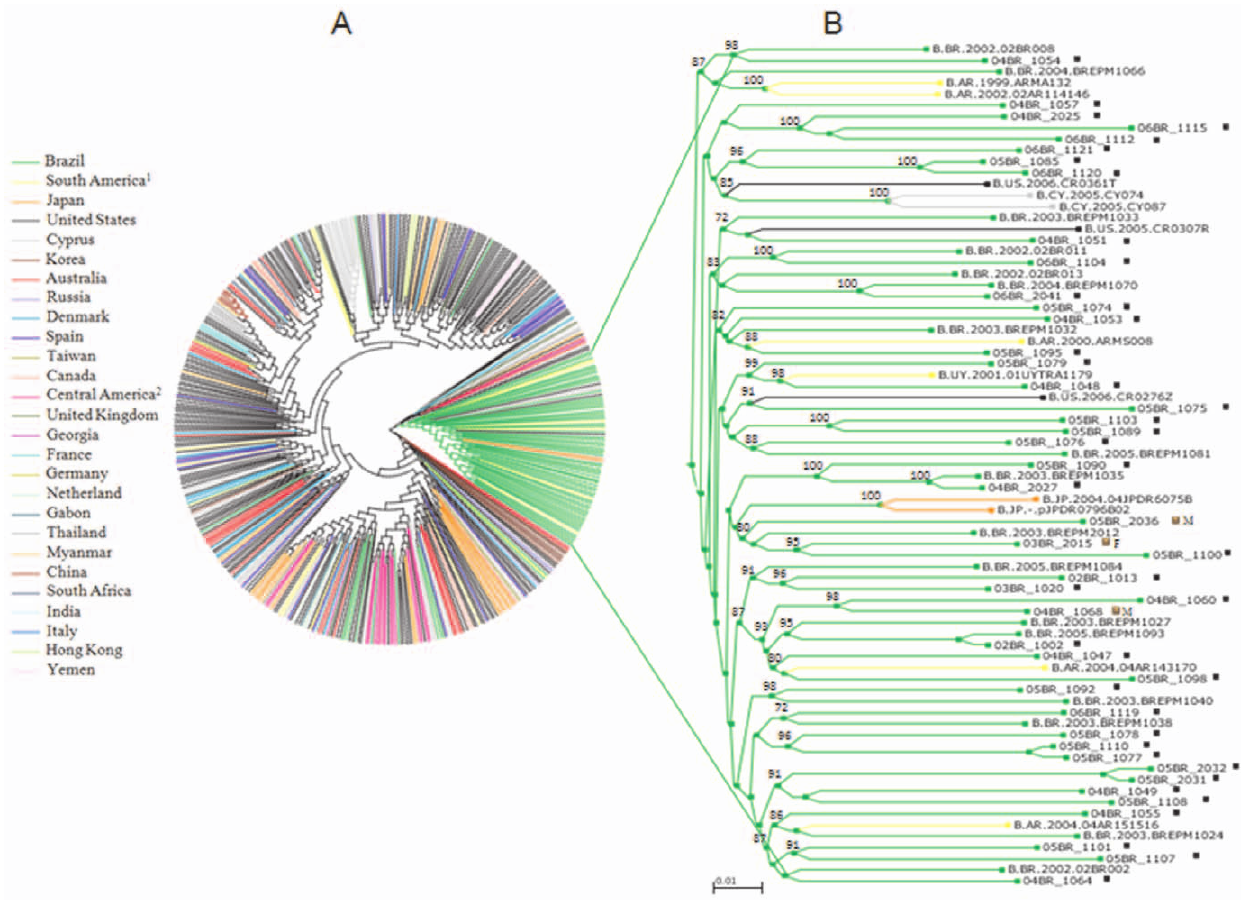
Figure 3. Phylogenetic relationships among subtype B HIV-1 NFLG sequences sampled from different countries. (a) Midpoint-rooted maximum-likelihood tree of 435 HIV-1 non recombinant subtype B NFLG sequences sampled from various global locations (colored branch). In addtion to previously published Brazilian subtype B NFLGs and other South American sequences from neighboring countries. The tree also contains 62 isolates sampled in Sa˜o Paulo from HIV-1 recently infected patients over a 4- year period between 2002–2006 (the present datasets). (b) For clarity, the Brazilian isolates branched as a monophyletic cluster was displayed. Annotation of samples is as follows: symbol-brown square-F indicates heterosexual female, and symbol-black square indicates homosexual male. The approximate likelihood ratio test (aLRT) values of $ 70% are indicated. The scale bar represents 0.01 nucleotide substitutions per site.